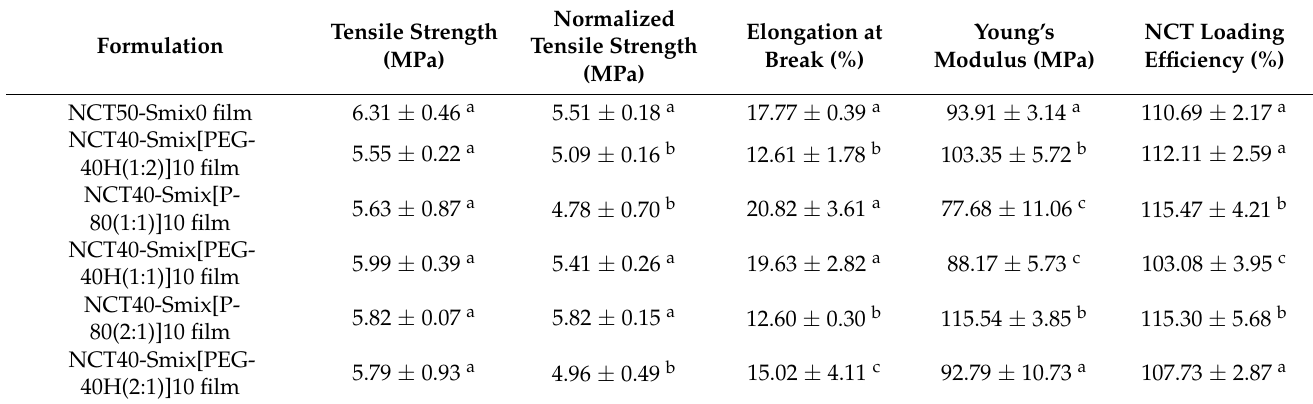
Table 3. Mechanical characteristics of the selected NCT-ME fast-dissolving films.